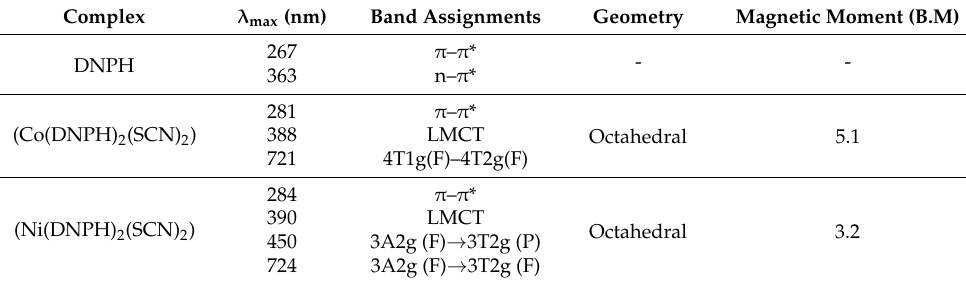
Figure 3. UV-visible spectrum of DNPH, along with the Co(II) and Ni(II) complexes. Table 3. UV-visible absorption spectral data and magnetic moment values. Complex Band Assignments